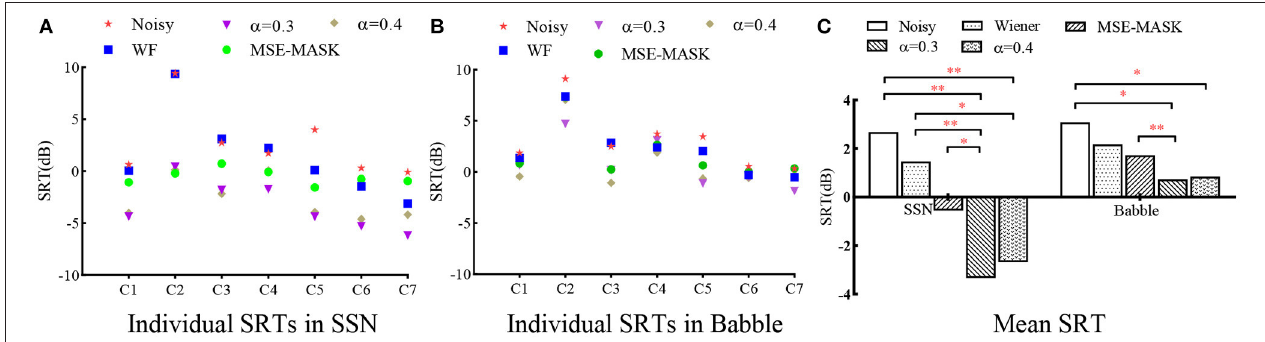
FIGURE 8 | CI users’ SRT results for different systems. (A) Individual results in SSN, (B) individual results in Babble, and (C) statistical analysis of the different methods. The asterisk in (C) represent significance analysis results. * indicates p < 0.0332, ** indicates p < 0.0021, *** indicates p < 0.0001.